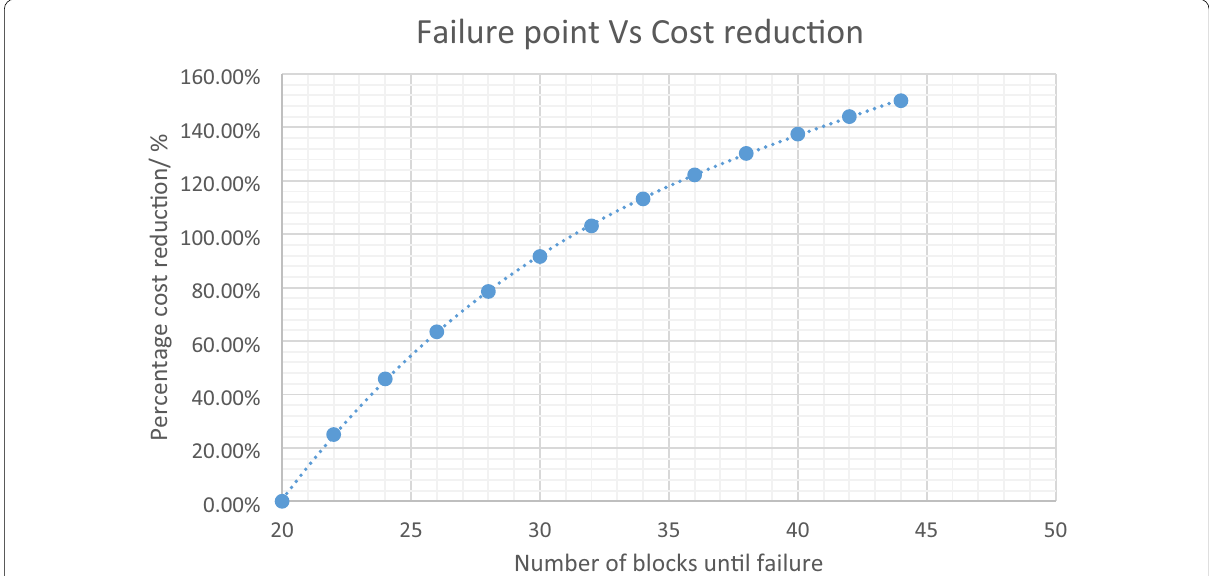
Figure 6 Number of blocks until failure vs cost